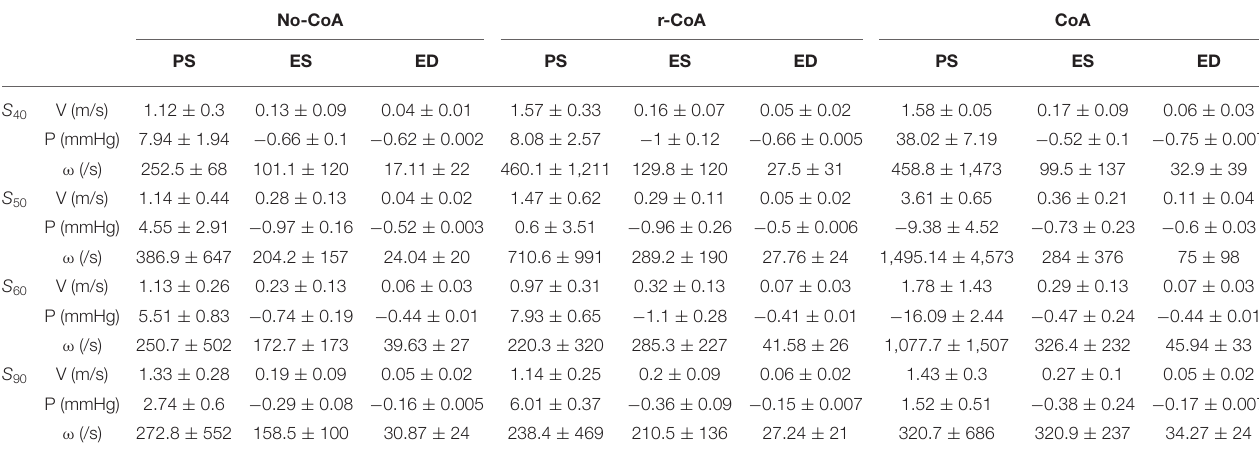
TABLE 1 | Average values of velocity (V), pressure (P), and vorticity ( ω ) on slices of 40, 50, 60, and 90. No-CoA r-CoA CoA PS ES